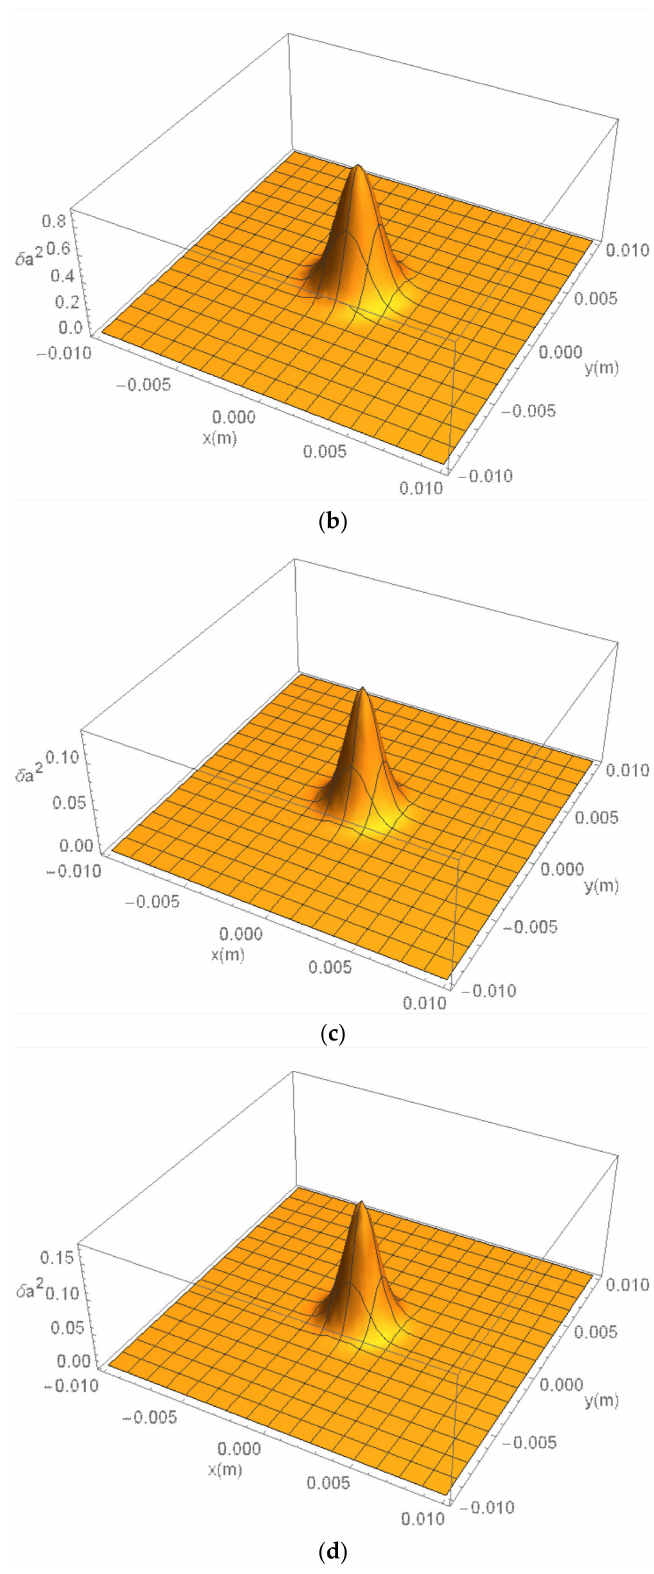
Figure 5. Evolutions of the field intensity of polarized radiation for the fundamental and higher-order modes of ( a ) h = 1 (Genesis simulation), ( b ) h = 1, ( c ) h = 3, and ( d ) h = 5 modes in the single-beam system with a fast beam for an emittance of ε n = 0.1 mm · mrad and an energy spread of 0.1% (color